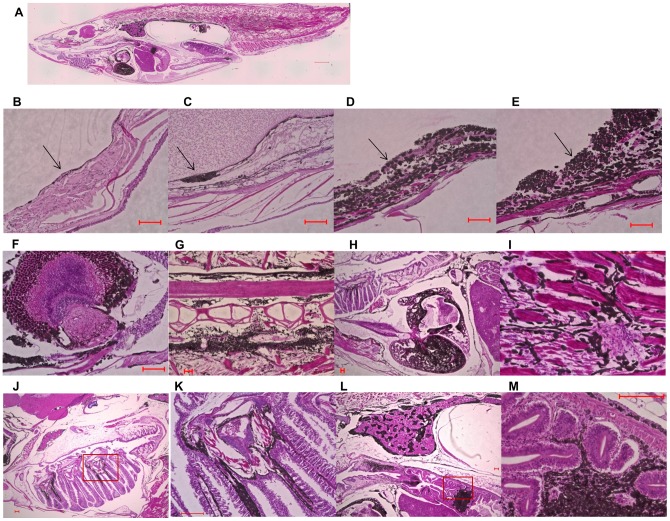
Hematoxylin-eosin staining of Tg
(
tyr:HRASG12V
)/Tg
(
hsp:cre
) medaka.(A) Overall image of fish #7 in Figure 3. (B)– (E), Melanophore layers (arrows) of a wild-type adult fish (B) as well as of fish #7 (C), #6 (D), and #4 (E) in Figure 3. (F)– (J), Eye, bone and spinal cord, heart, muscle, and gill, respectively, of fish #7 in Figure 3. (K) Enlarged image of the boxed region in (J). (L) Kidney and digestive duct of fish #7 in Figure 3. (M) Enlarged image of the boxed region in (L). Scale bars: 1 mm (A) and 0.1 mm (B–M).